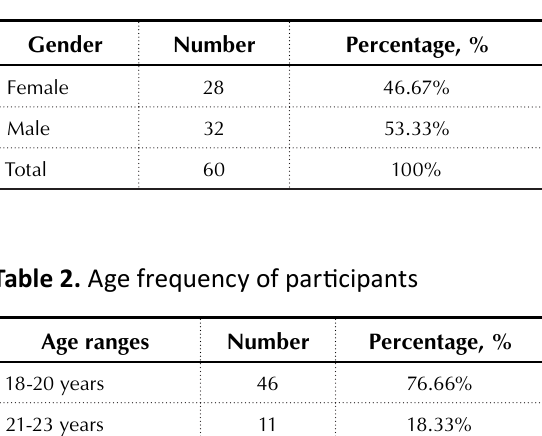
Table 1. Participants gender